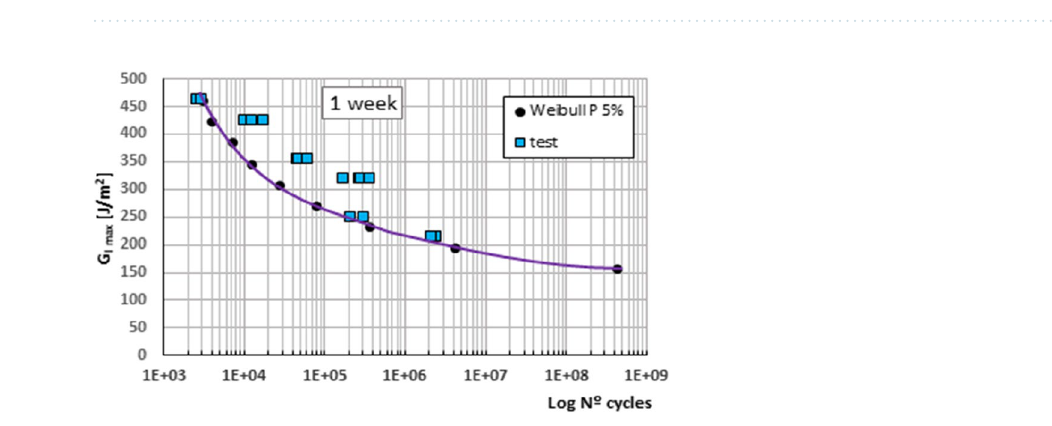
Figure 2. Fatigue initiation curves of material under mode I fracture, for 5% probability of fracture, unexposed material.